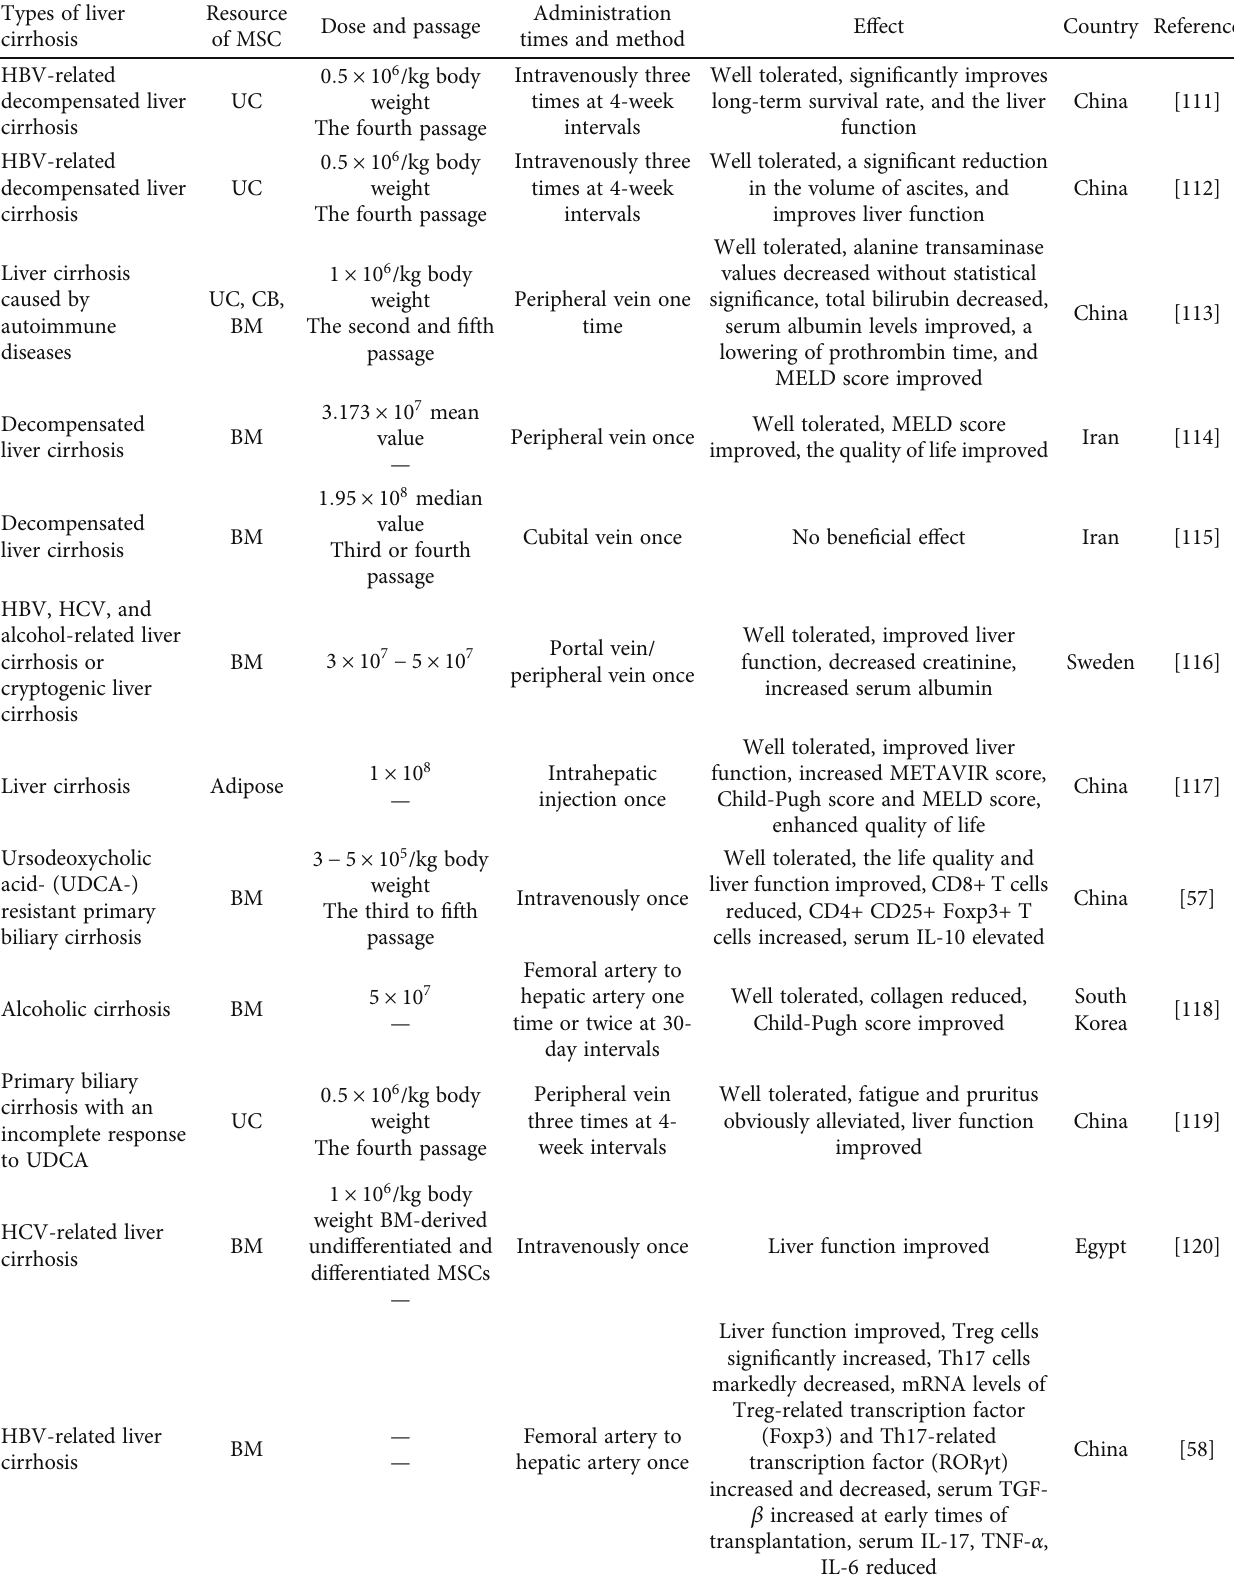
Table 1: Clinical trial articles of MSCs in the treatment of liver cirrhosis in